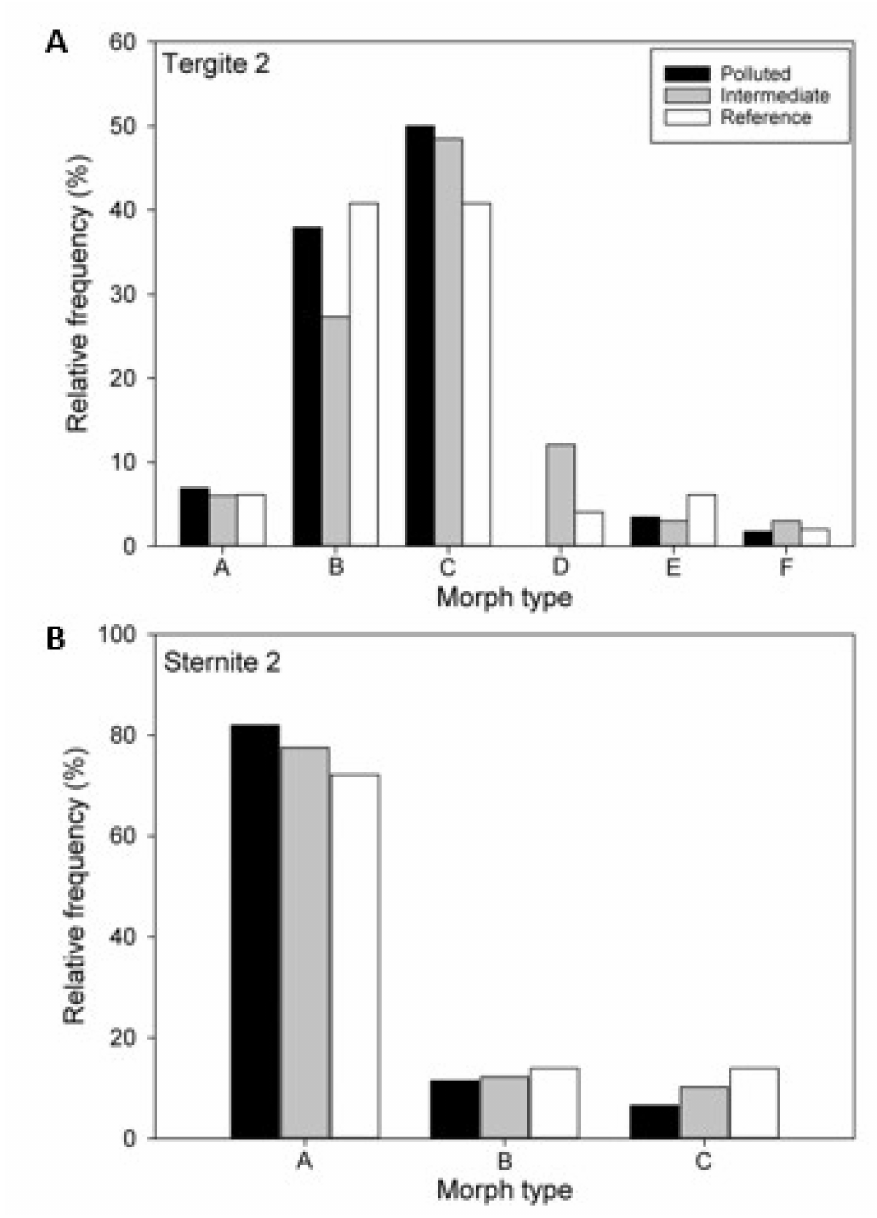
Figure 4. Relative frequencies of different color morphs of 2nd tergites ( A ) and 2nd sternites ( B ) of common wasps in three pollution